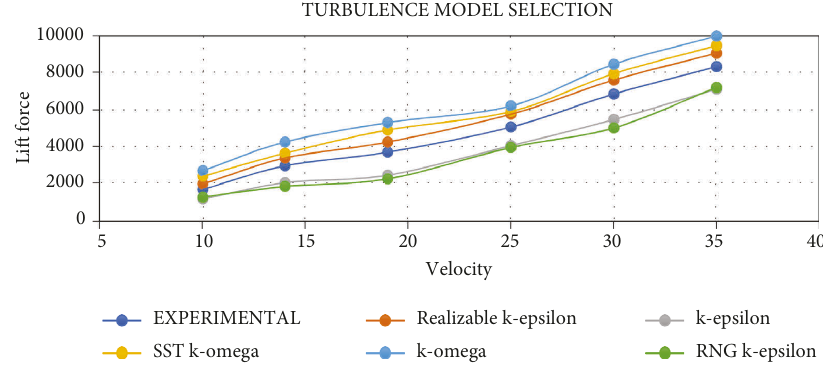
Figure 1: Turbulence model selection.